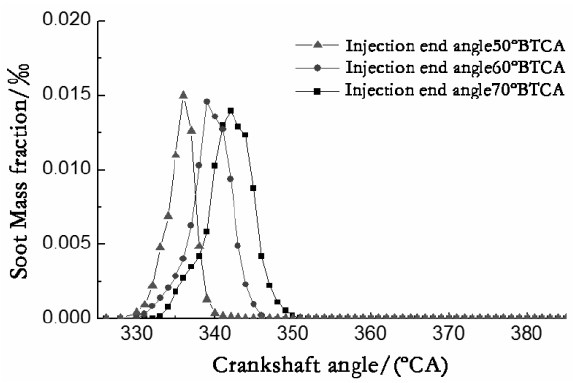
Figure 16. Soot curves corresponding to different injection end angles.